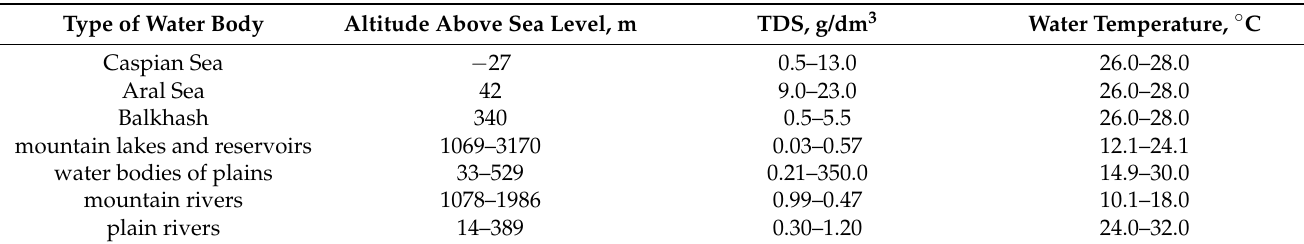
Table 2. Types of the surveyed water bodies, their altitude above sea level, TDS, and maximum water temperature. Type of Water Body Altitude Above Sea Level, m TDS, g/dm 3 Water Temperature, ◦ C Caspian